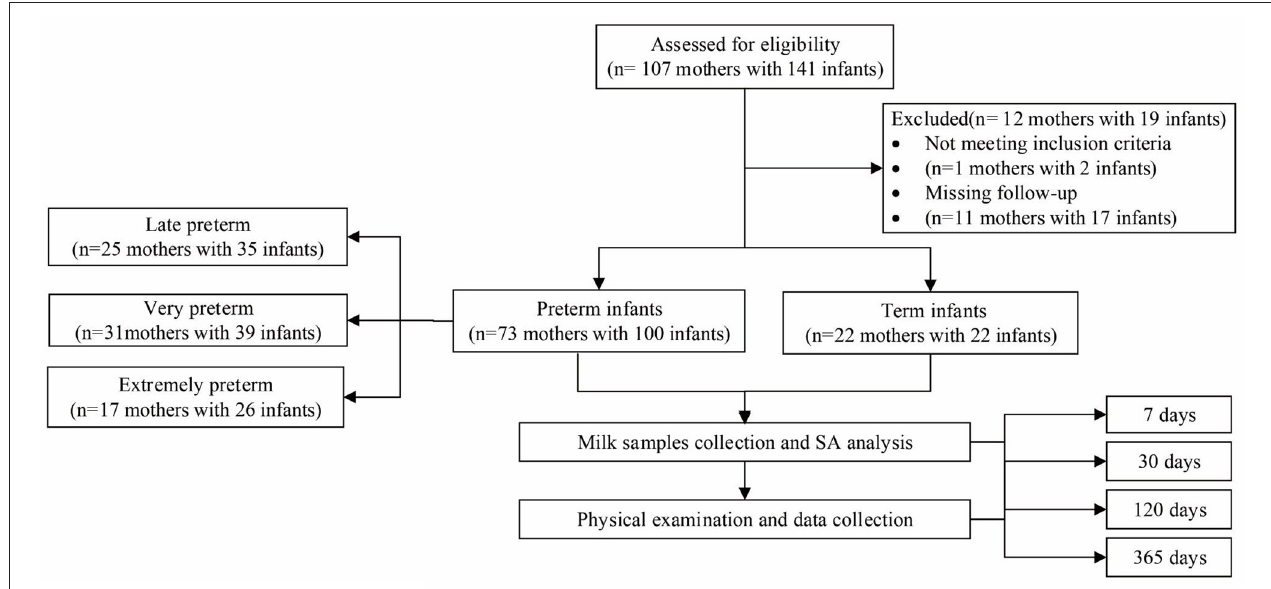
FIGURE 1 | Flow chart of